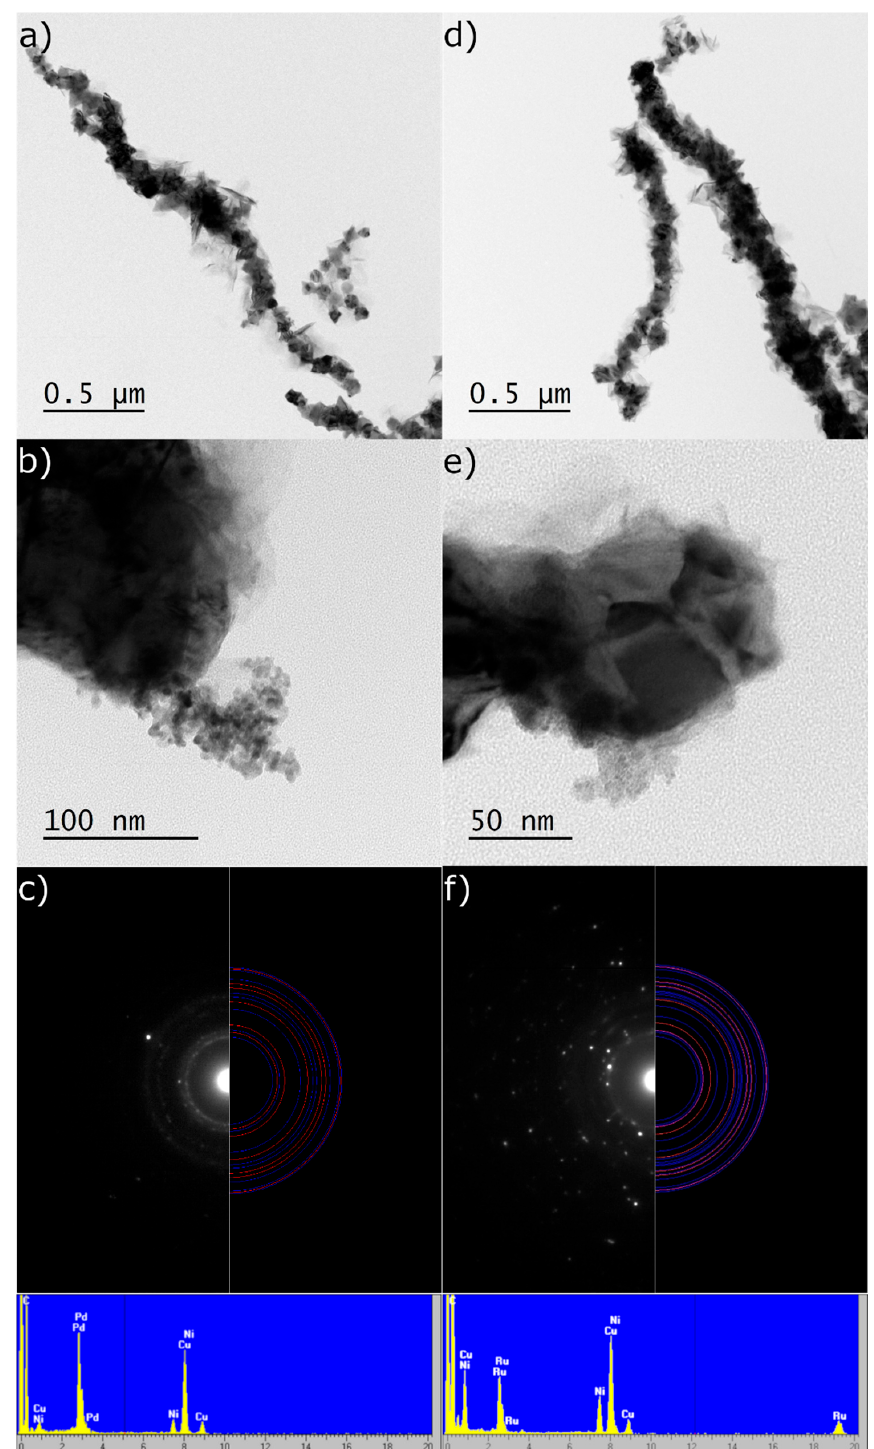
Figure 5. TEM micrographs of the Ni nanowires (NWs) with ( a – c ) Pd nanoparticles and with ( d – f ) Ru nanoparticles. ( a , b ) and ( d , e ) show the recorded bright field images at different magnifications. ( c ) and ( f ) present the recorded selected area electron diffraction patterns from regions that are shown in ( b ) and ( e ), respectively. Red circles correspond to the theoretical diffraction rings for Ni whereas the blue circles correspond to the theoretical diffraction rings for ( c ) Pd and ( f ) Ru. The EDS spectra were shown inside.